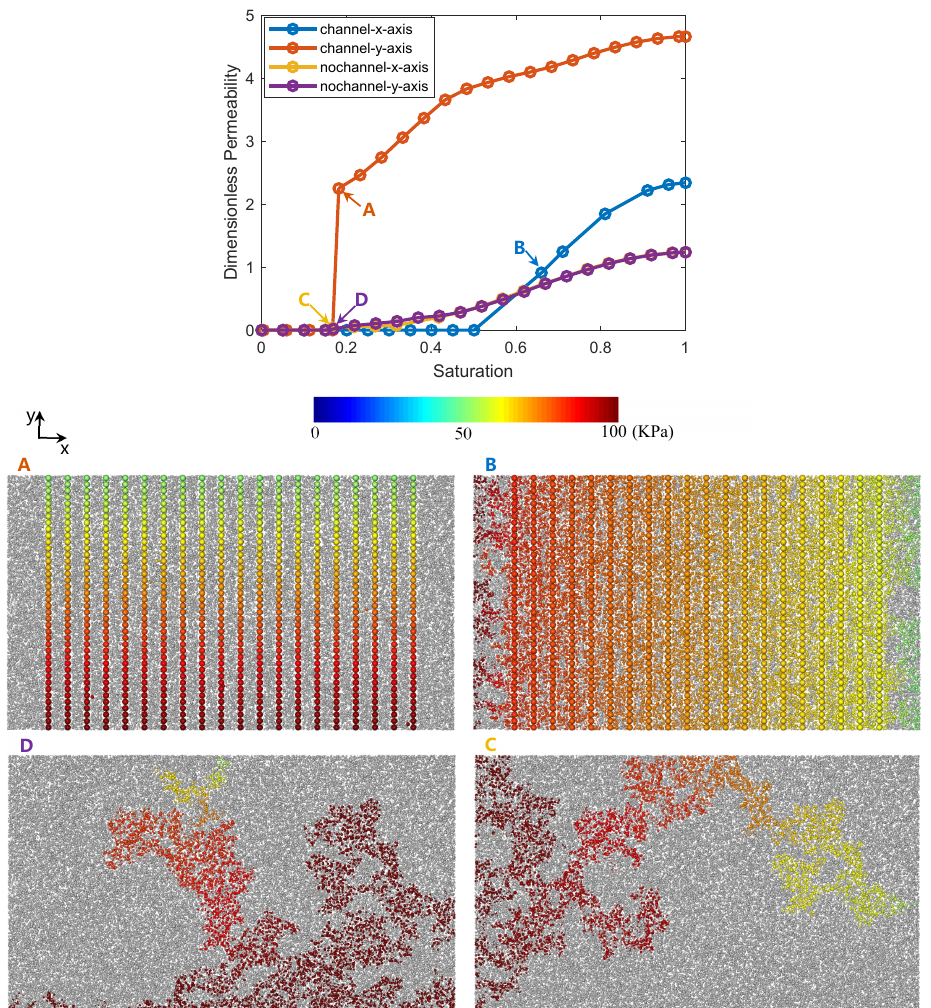
Figure 12. Drainage relative permeability curves and 4 chosen pressure fields ( A – D ) in pore networks with ( A , B ) and without ( C , D )